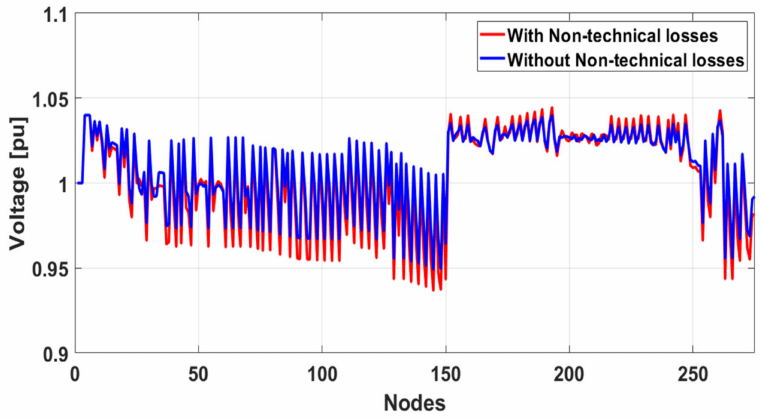
Figure 8. IEEE 123-bus test system voltage profiles at all nodes for the most loaded condition at 7:45 pm, considering non-technical losses (red) and without non-technical losses (blue).